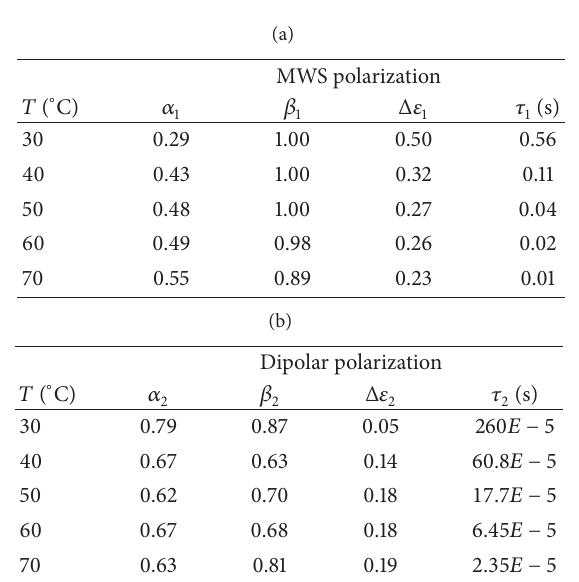
Table 4: Optimum fit parameters for MWS and dipolar relaxations in Figure